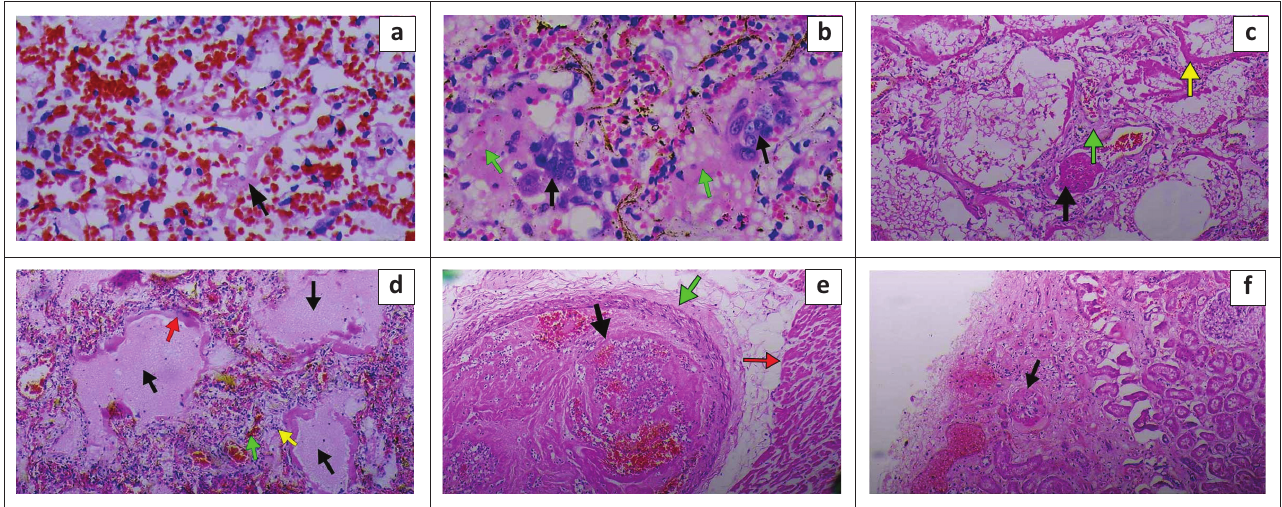
FIGURE 1: Haematoxylin and eosin staining of various organs in SARS-CoV-2-induced deaths at the 37 Military Hospital, Accra, Ghana, May 2020. (a) Severe congestion with intra-alveolar deposition of fibrinous tissue (black arrow) × 400. (b) Type 2 pneumocyte hyperplasia (black arrows), diffuse alveolar damage (DAD) with early hyaline membrane (HM) formation (green arrows) × 400. (c) DAD with prominent HM formation (yellow arrow), interstitial fibrosis (green arrow) and a thrombus in a small pulmonary artery (black arrow) × 100. (d) DAD with prominent HM (red arrow), oedema (black arrows), congestion (green arrow), interstitial fibrosis and lymphocytic infiltrates (yellow arrow) × 100. (e) Thrombus formation (black arrow) in a branch of a coronary artery (green arrow) in the heart muscle (red arrow) × 400. (f) Micro- thrombus (black arrow) in a renal arteriole × TABLE 3: Summary of SARS-CoV-2 associated deaths during post-mortem at the 37 Military Hospital, Accra, Ghana, May 2020. Underlying cause of death